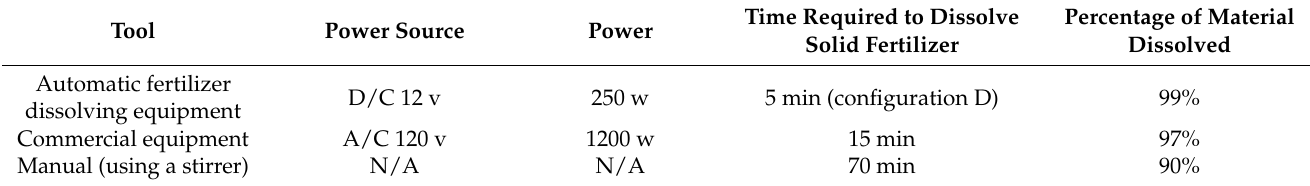
Table 1. Comparison of results in time and efficiency in the dissolution of agricultural salts.